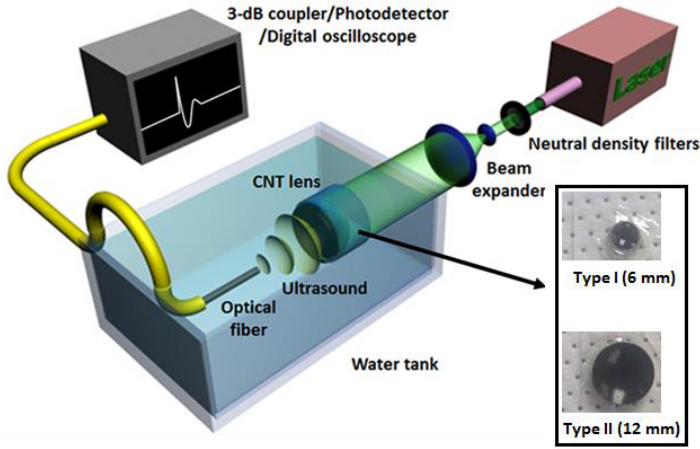
Figure 5. Measurement setup for the LGUS characterization. The laser bean is expanded and then irradiated on the CNT lens. The generated ultrasound is optically detected by scanning the fiber-optic hydrophone. Inset: two types of CNTs–PDMS focused LGUS transmitters. Reproduced with permission from [30], Nature Publishing Group, 2012.